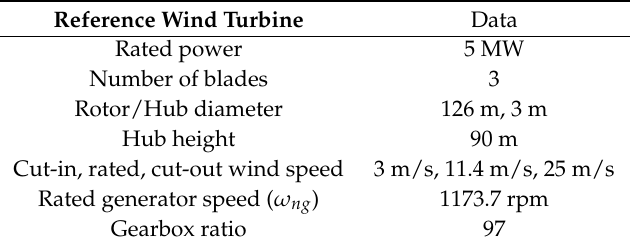
Table 2. Gross properties of the wind turbine.